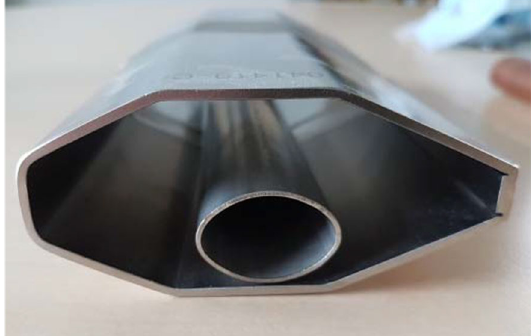
FIG. 9. Cross section of the DBA arc chamber (octagon) and DDBA arc chamber